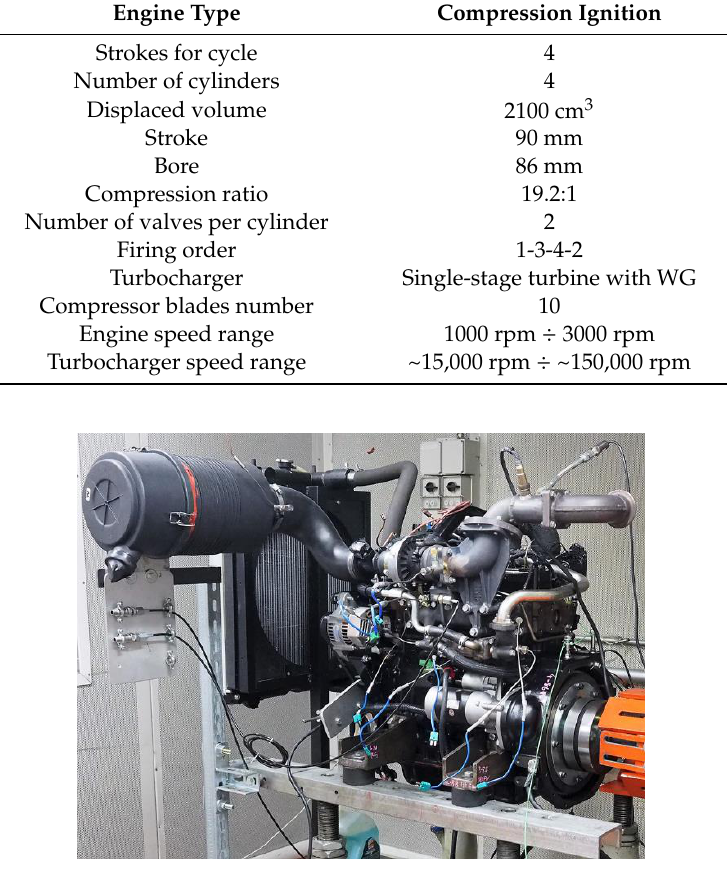
Figure 5. Tested engine at the test bench.